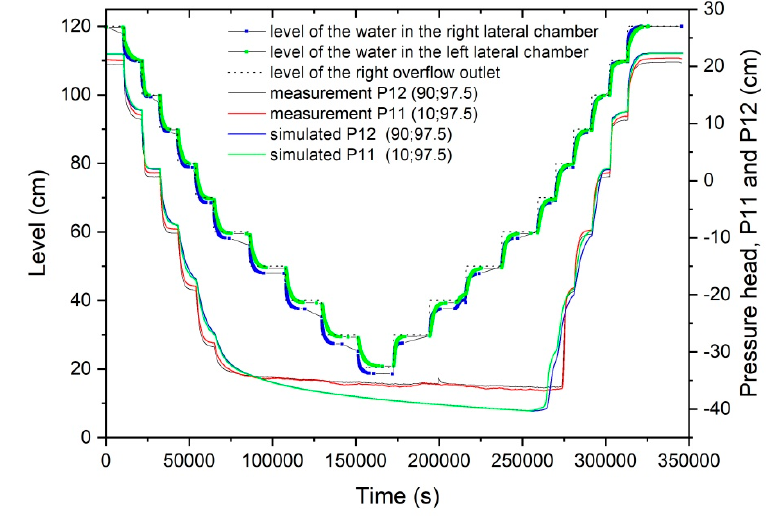
Figure 2. First experiment: position of the right overflow outlet (dotted black line) and consequence on the level of water monitored in the right lateral (solid black line with blue square symbols) and left lateral (solid black line with green square symbols) chambers. Evolution of measured pressure head (P11 x = 10 cm / z = 97.5 cm: solid red line, P12 x = 90 cm / z = 97.5 cm: solid black line) and simulated values (P11: solid green line, P12: solid blue line).